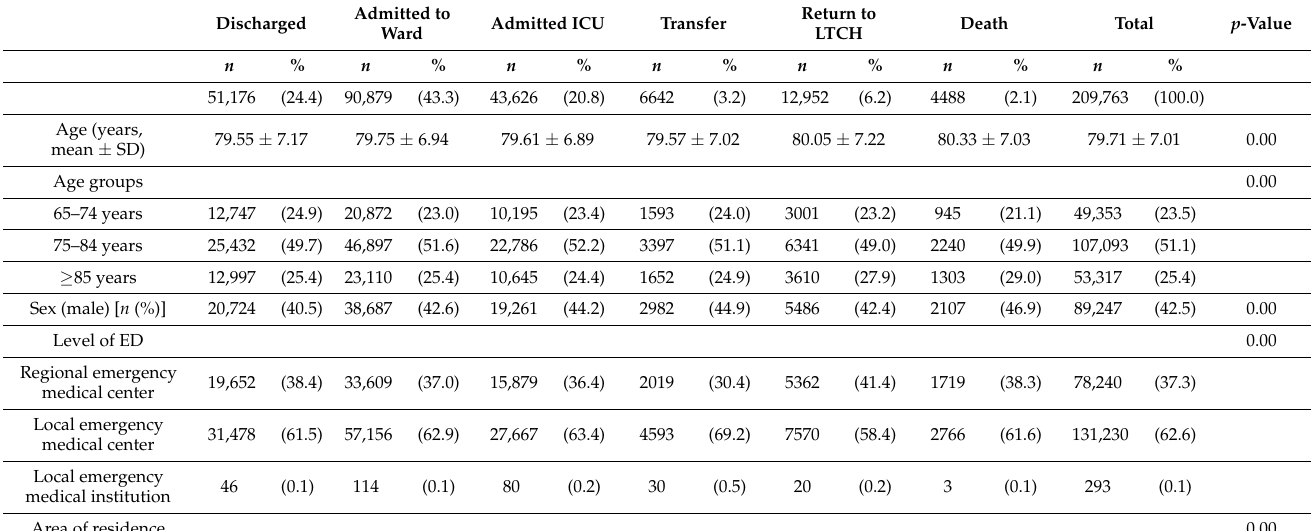
Table 2. Comparison of groups according to ED outcomes among patients transferred from